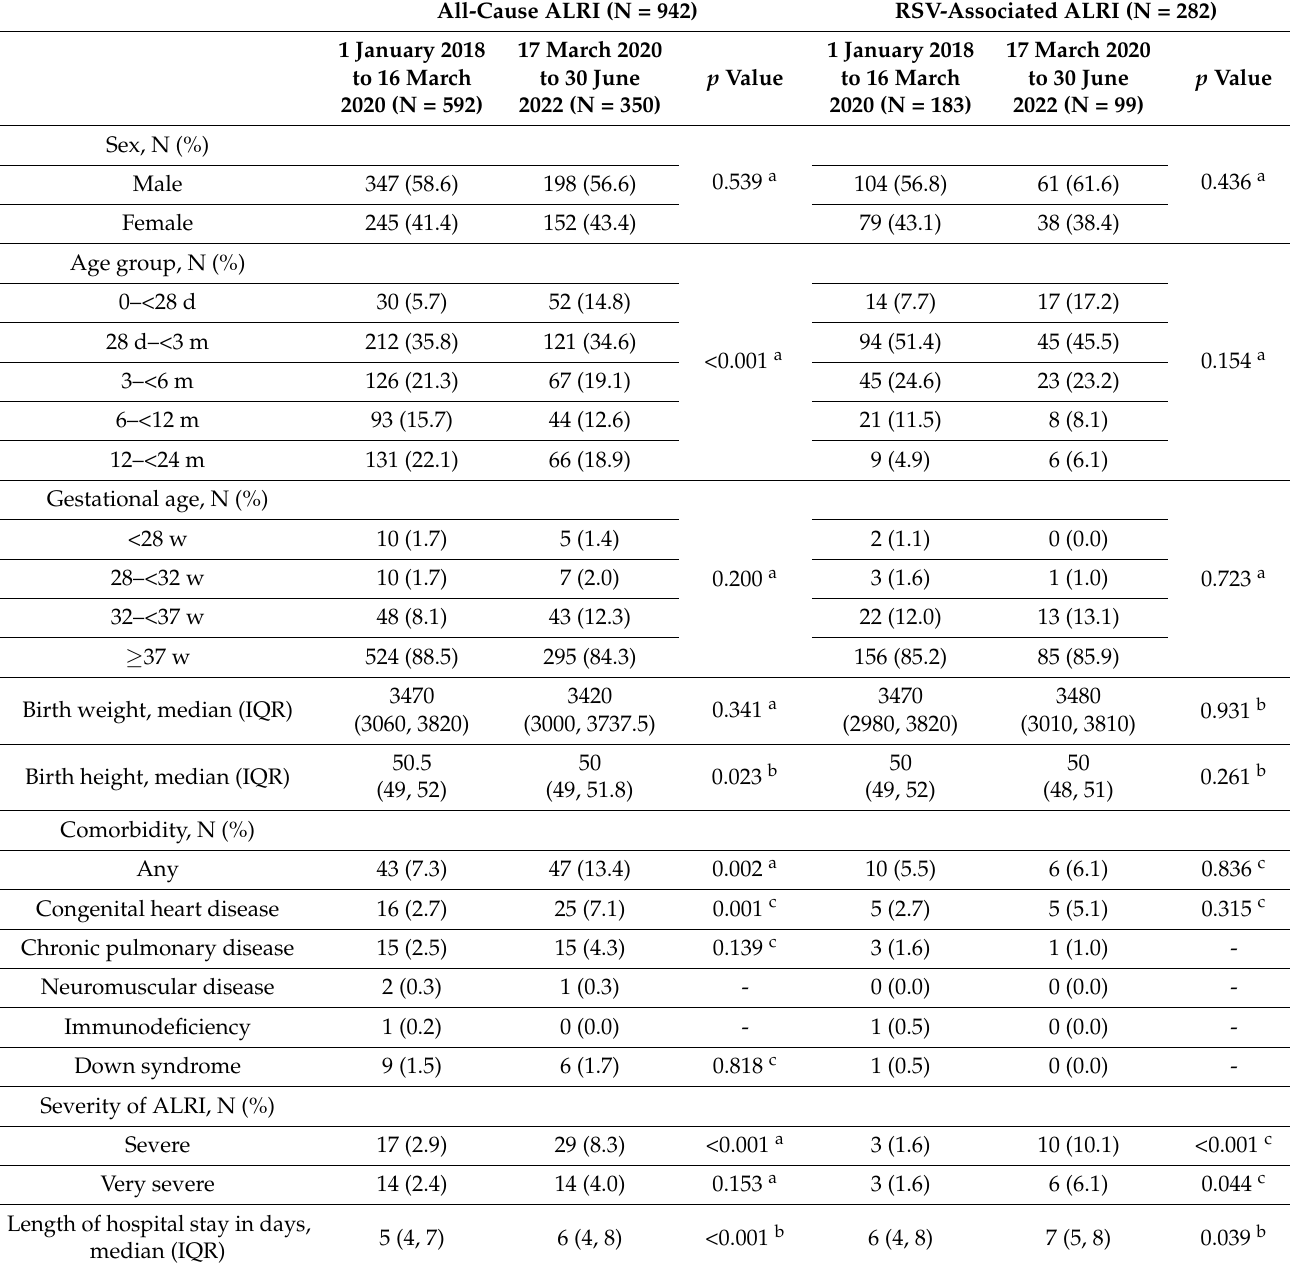
Table 1. Basic characteristics of study